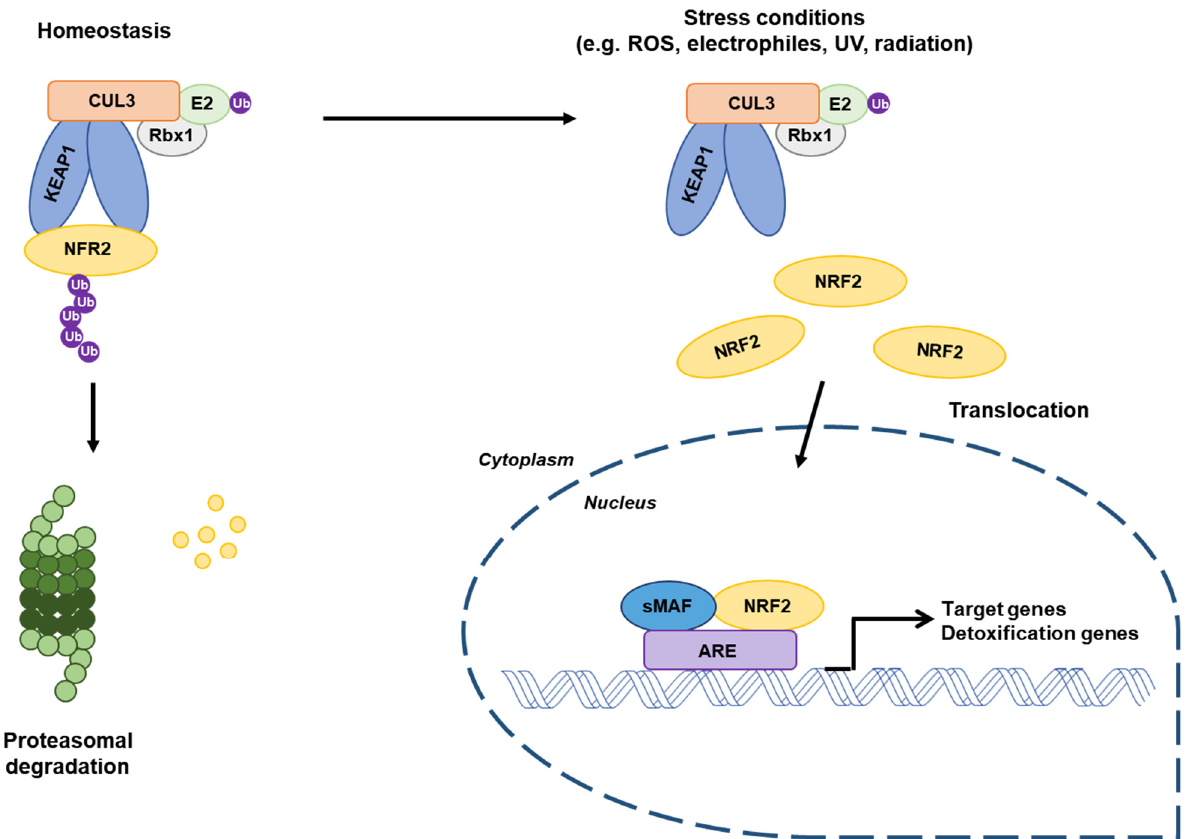
Figure 2. Regulation of NRF2 molecular mechanisms. Under basal conditions, NRF2 binds to its suppressor KEAP1 in the cytosol and interacts with the Cul3-RBX1 E3 ubiquitin ligase that constantly leads to NRF2 ubiquitination and proteasomal degradation. Under stressed conditions, conformational changes in KEAP1 and dissociation of NRF2 occur. Stabilized NRF2 translocates into the nucleus and forms a dimer with sMAFs proteins. The complex binds to antioxidant responsive elements sequences, promoting the transcription of target genes. RBX1, RING-box protein. Adapted from Jaramillo and Zhang [54].